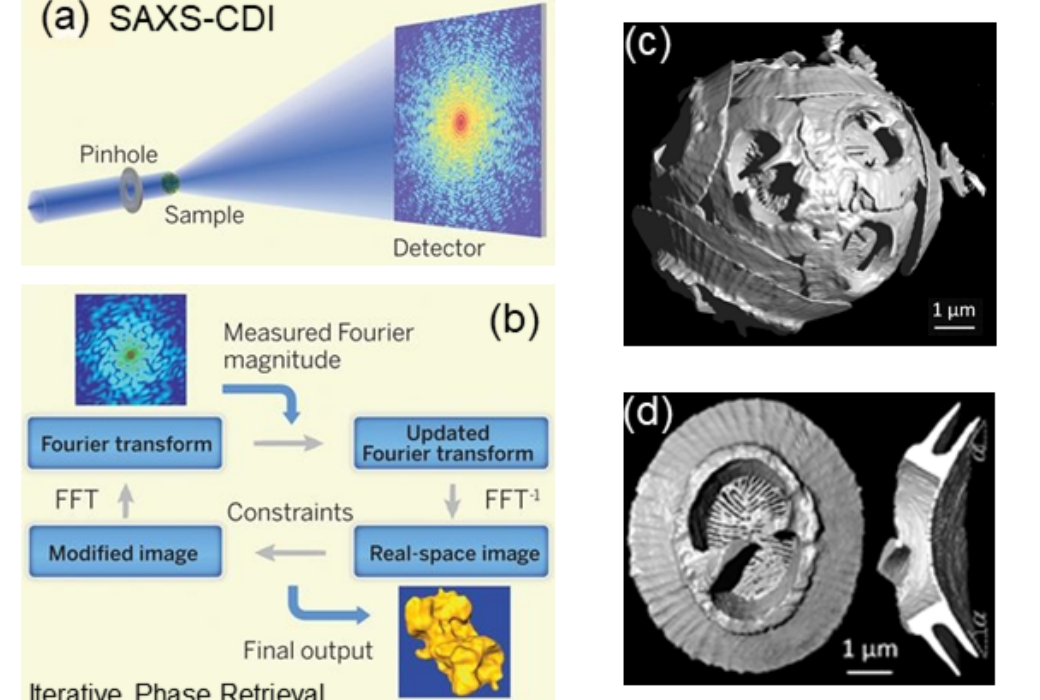
Figure 16. ( a ) The optical and detection schemes used in SAXS-CDI. A plane wave illuminates the noncrystalline specimen, and an oversampled speckle pattern is recorded by a high-resolution detector. ( b ) The phase retrieval procedure involves iterating back and forth between real and reciprocal space. In each iteration, various real space physical constraints such as positive electron density, partially overlapping regions, etc. are imposed, while the measured Fourier amplitude is updated in reciprocal space. Panels (a,b) are adapted from J. Miao et al. [10] with permission from the American Association for the Advancement of Science, c AAAS 2015. ( c ) 3D images of coccospheres of G. oceanica (cid:13) RCC1314 reconstructed by tomographic SAXS-CDI. ( d ) Distal view of the coccolith and a side view along the major axis after sectioning half of the extracted coccolith. Panels (c,d) are adapted